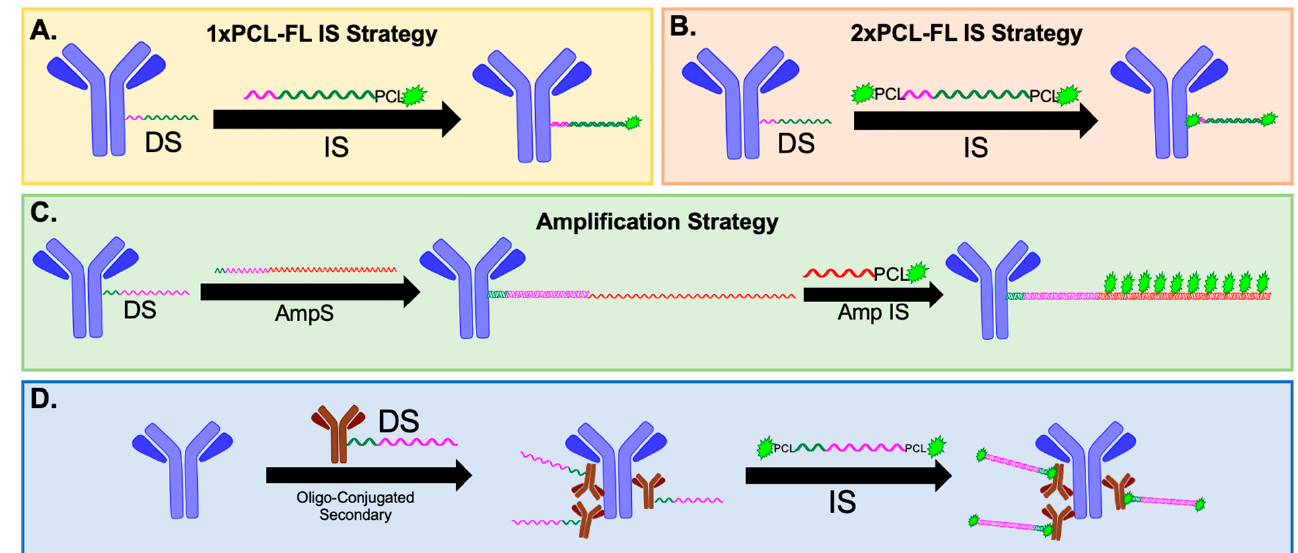
Figure 1. Ab-oligo cyCIF strategies. Multiple methods of fluorescent labeling of Ab-oligo conjugates have been investigated including ( A ) a complementary imaging strand (IS, 26 nt) with a single fluo- rophore and photocleavable linker (PCL) and ( B ) a complementary IS (26 nt) with two fluorophores and two PCLs that hybridize to the docking strand (DS, 28 nt) on the antibody. ( C ) An amplification strategy has been developed and optimized that utilizes an amplification strand (AmpS, 198 nt) that hybridizes with DS (28 nt) and has an unhybridized region that can hybridize up to ten amplification IS (Amp IS, 15 nt) that each contain a fluorophore and PCL for increased signal intensity. ( D ) The oligonucleotide conjugation strategy was also extended to secondary antibodies to permit Ab-oligo cyCIF of sensitive primary antibodies where DS (28 nt) are conjugated to secondary antibodies and detected using complementary 2 × PCL-FL IS (26